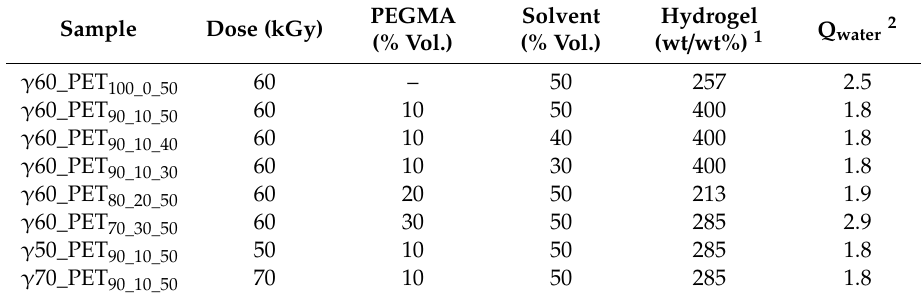
Table 2. Surface modification of PET fabric with hydrogel using the direct gamma irradiation method; water was used as